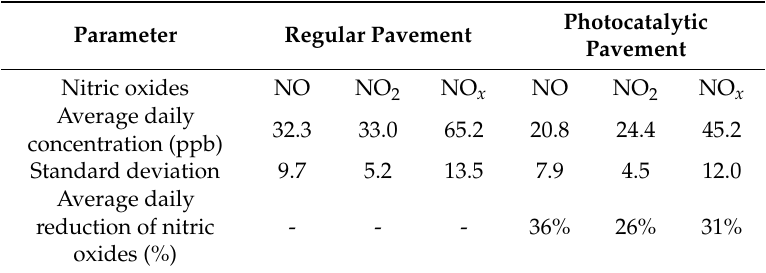
Table 1. Average values of nitric oxide concentrations measured from 10 a.m. to 6 p.m. at regular and photocatalytic pavement at the Daszynskiego roundabout.